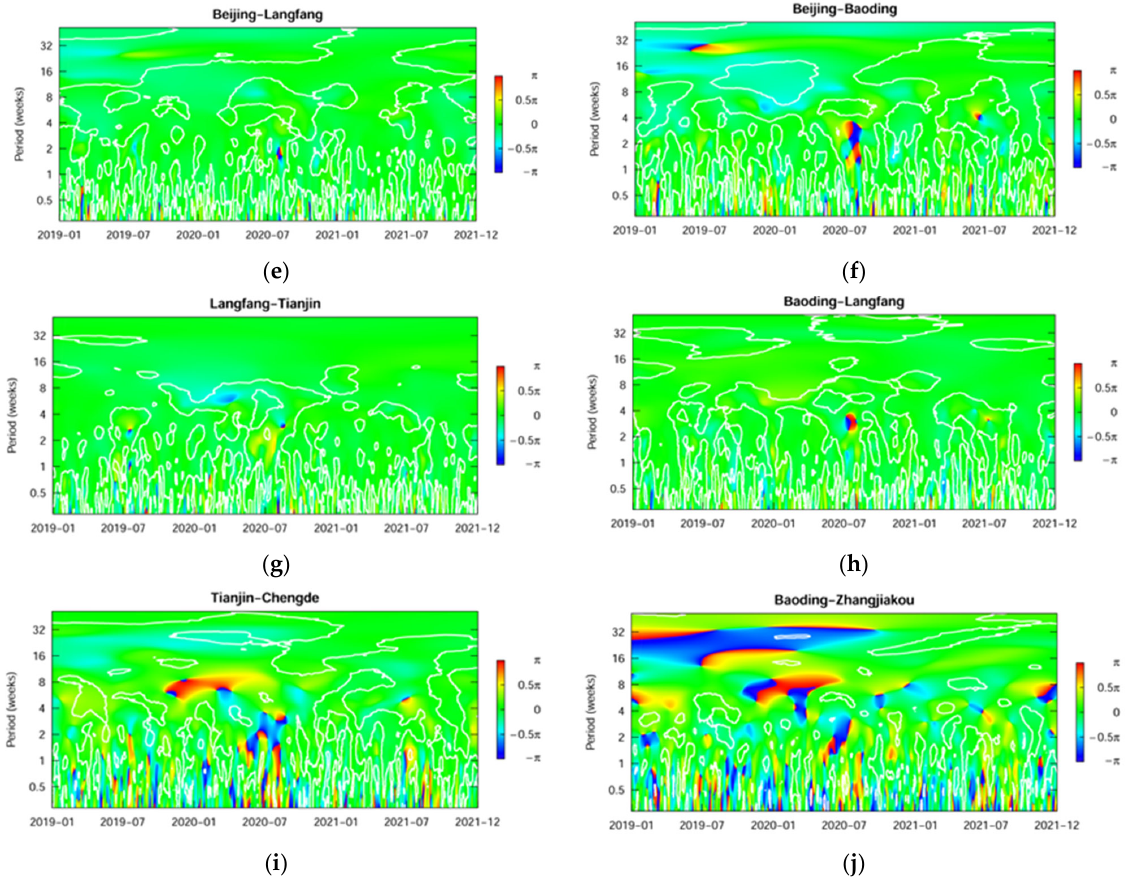
Figure A3. The phase difference. Note: The horizontal axis is time and the vertical axis is the periodicity length in weeks. The phase difference ranges from blue (- π ) to red ( π ), which represents the characteristics of phase difference (see Equation (5)). The white contour marks the 5% significance level estimated from Monte Carlo simulations. ( a ) Beijing–Zhangjiakou. ( b ) Beijing–Chengde. ( c ) Chengde– Zhnagjiakou. ( d ) Beijing–Tianjin. ( e ) Beijing–Langfang. ( f ) Beijing–Baoding. ( g ) Langfang–Tianjin. ( h ) Baoding–Langfang. ( i ) Tianjin–Chengde. ( j )